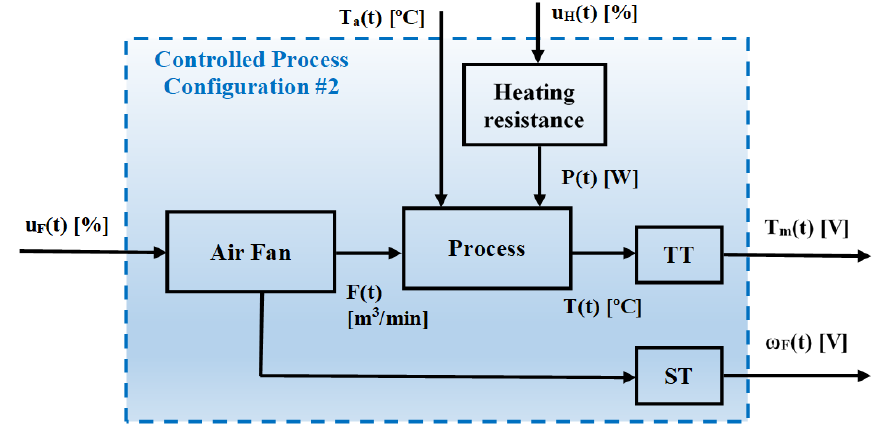
Figure 12. Block diagram for the controlled process configuration #2.